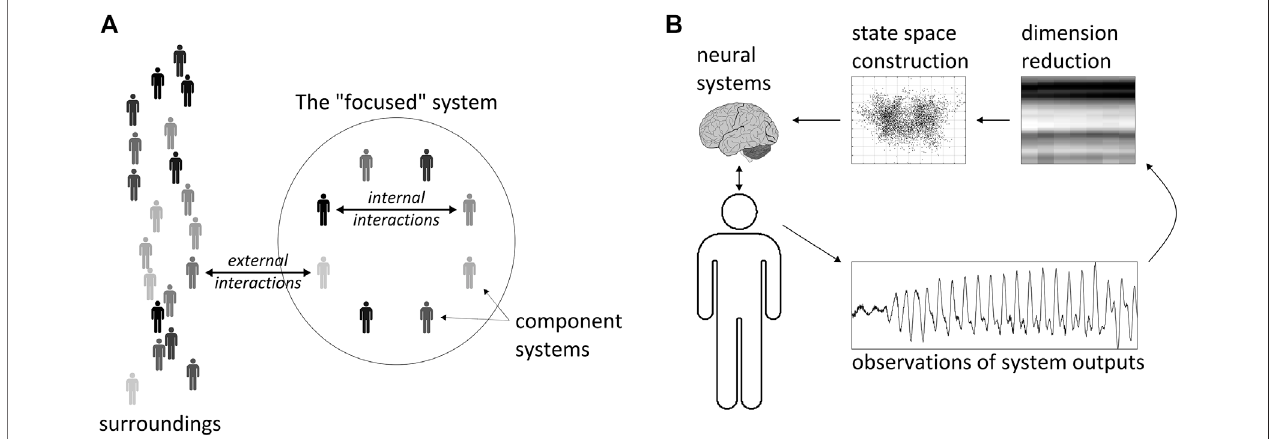
FIGURE 2| Schematic illustration of the physical system analogy. (A) the focused system iscomprised ofcomponent systems which may interactwith each other and the surroundings. (B) each component system is associated with a state space that we construct through dimensionality reduction methods.